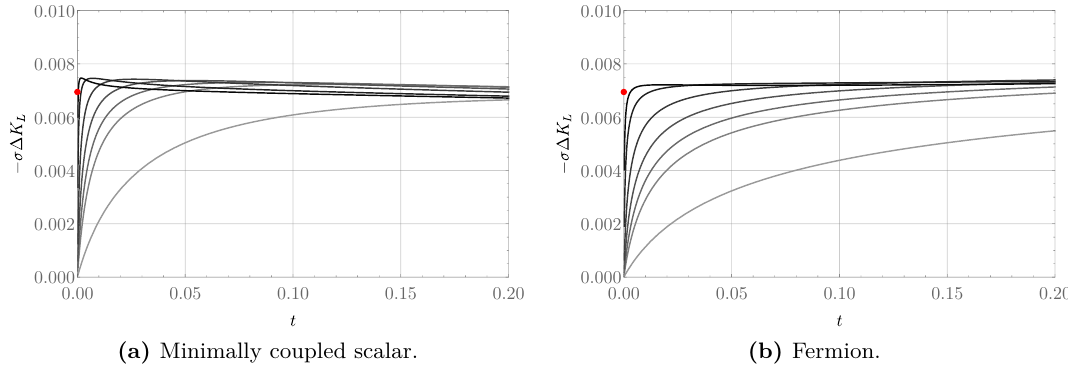
Figure 9. The small- t behavior of ∆ K L for the minimally coupled scalar (left) and the Dirac fermion (right) on the geometries (5.7) with α = 3 π . From lightest to darkest, the curves correspond to (cid:15) = 0 . 9 , 0 . 95 , 0 . 96 , 0 . 97 , 0 . 98 , 0 . 99 , and 0 . 995 . The red dot indicates the t = 0 value − 1 / 144 expected on the conical defect geometry with (cid:15) = 1 .